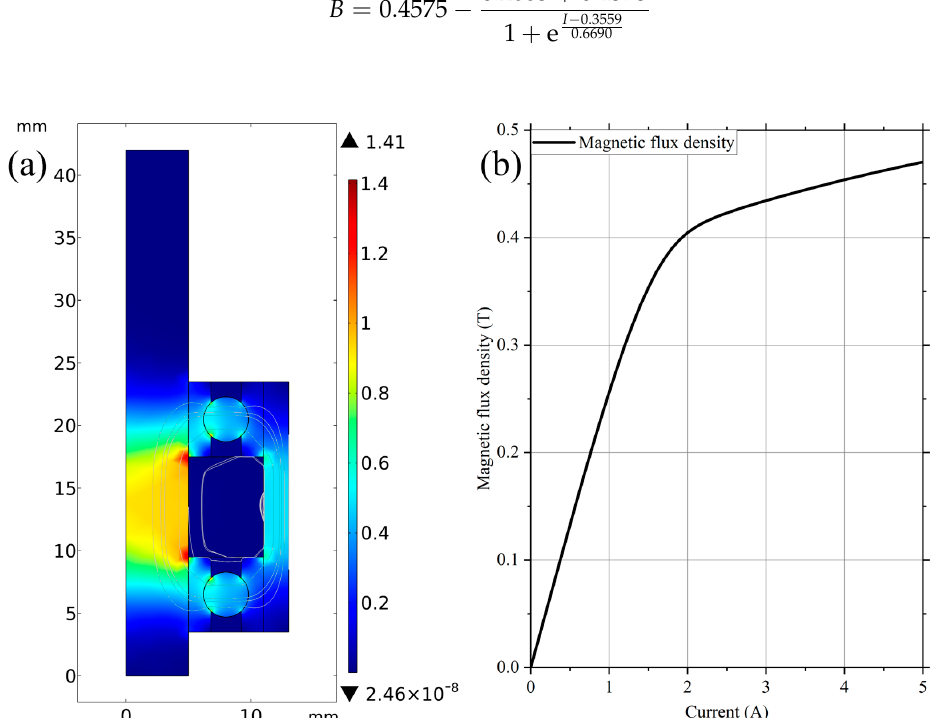
Figure 4. Magnetic field simulation of the MR damper. ( a ) Magnetic flux density distribution of the MR damper when the current in the coil is 1 A. ( b ) Magnetic flux density at the area of the MRG around the rolling balls.